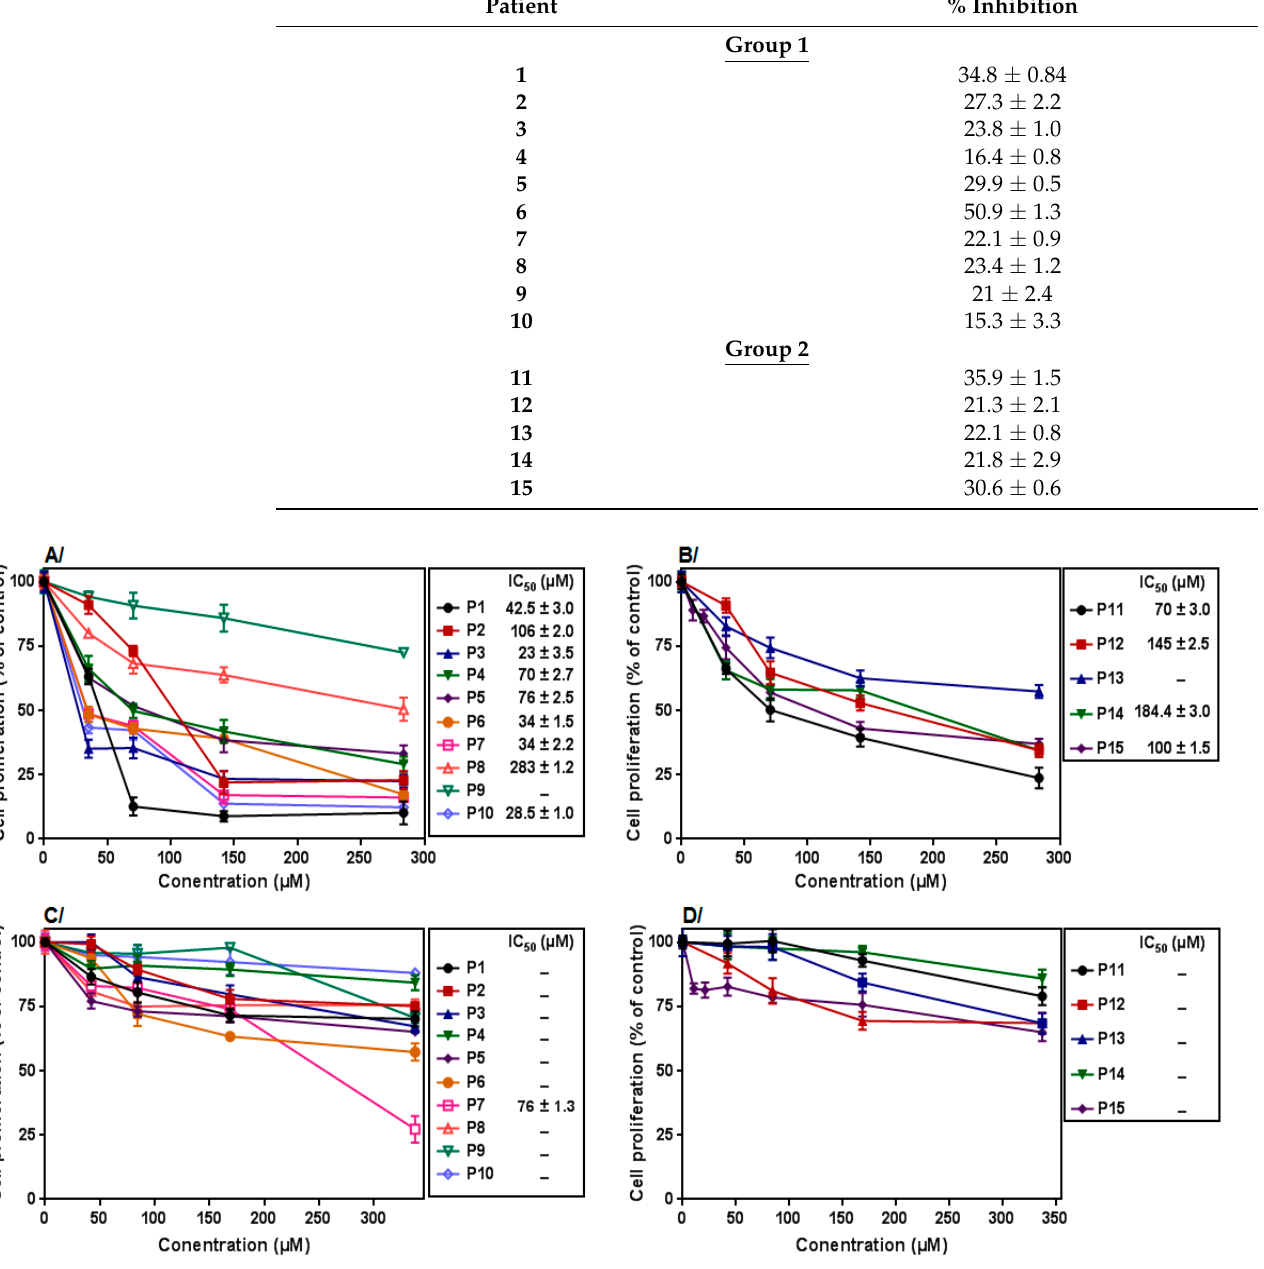
Figure 3. Anti-proliferative activity of compounds 3d and 4a on primary CML cells: ( A ) cells isolated from patients at diagnosis (group 1) treated with compound 3d for 72 h; ( B ) cells isolated from resistant patients (group 2) treated with compound 3d ; ( C ) cells isolated from group 1 treated with compound 4a ; ( D ) cells isolated from group 2 treated with compound 4a . Data represent the mean ± SEM of three independent experiments performed in triplicate. All data were statistically significant ( p <